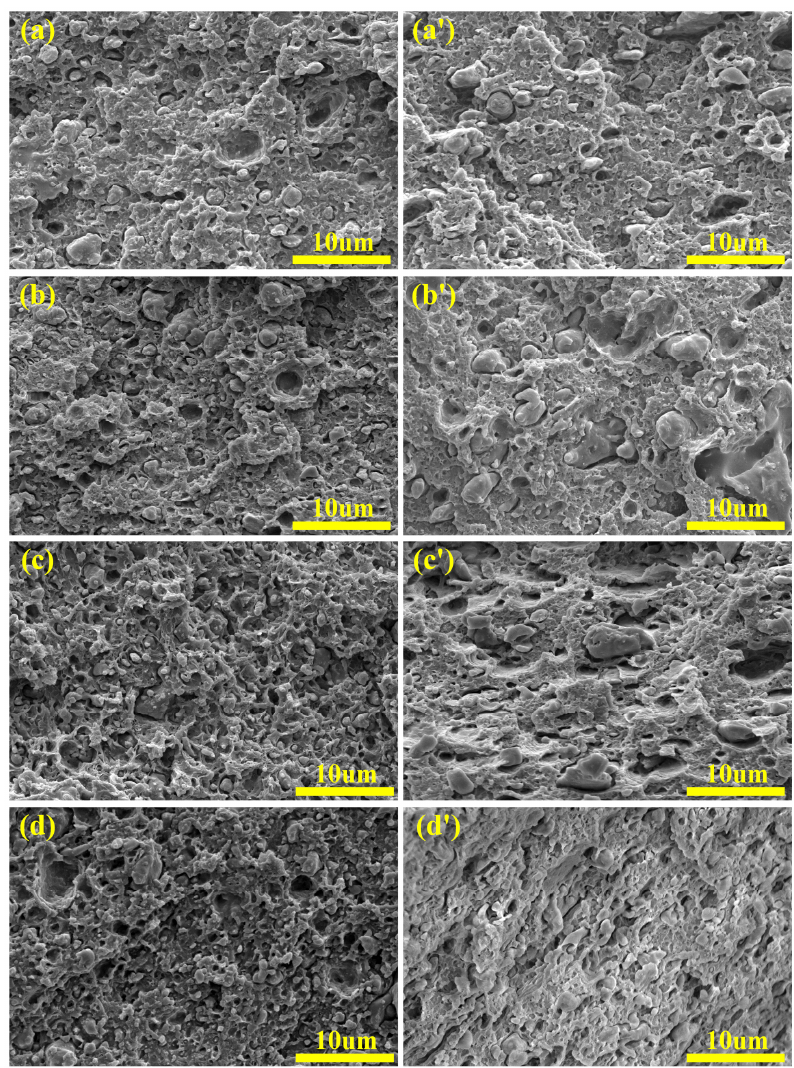
Figure 5. SEM micrographs of impact fracture surfaces of the rABS/SEBS blends and SEM micrographs of impact fracture surfaces of the rABS / SEBS blends and rABS/SEBS-g-MAH blends: ( a ) rABS/SEBS 95/5; ( a’ ) rABS/SEBS-g-MAH 95/5; ( b ) rABS/SEBS 90/10; rABS / SEBS-g-MAH blends: ( a ) rABS / SEBS 95 / 5; ( a’ ) rABS / SEBS-g-MAH 95 / 5; ( b ) rABS / SEBS 90 / 10; ( b’ ) rABS/SEBS-g-MAH 90/10; ( c ) rABS/SEBS 85/15; ( c’ ) rABS/SEBS-g-MAH 85/15; ( d ) rABS/SEBS ( b’ ) rABS / SEBS-g-MAH 90 / 10; ( c ) rABS / SEBS 85 / 15; ( c’ ) rABS / SEBS-g-MAH 85 / 15; ( d ) rABS / SEBS 80 / 20; 80/20; and, ( d’ ) rABS/SEBS-g-MAH 80/20. and, ( d’ ) rABS / SEBS-g-MAH 80 /